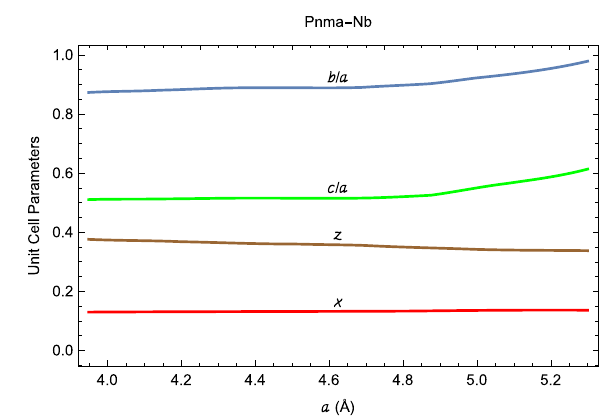
Fig. 4 The unit-cell parameters of orthorhombic Pnma -Nb, including two internal coordinates, x and z , as functions of the lattice constant a , at zero temperature. The corresponding pressures span the ~(0, 1000) GPa